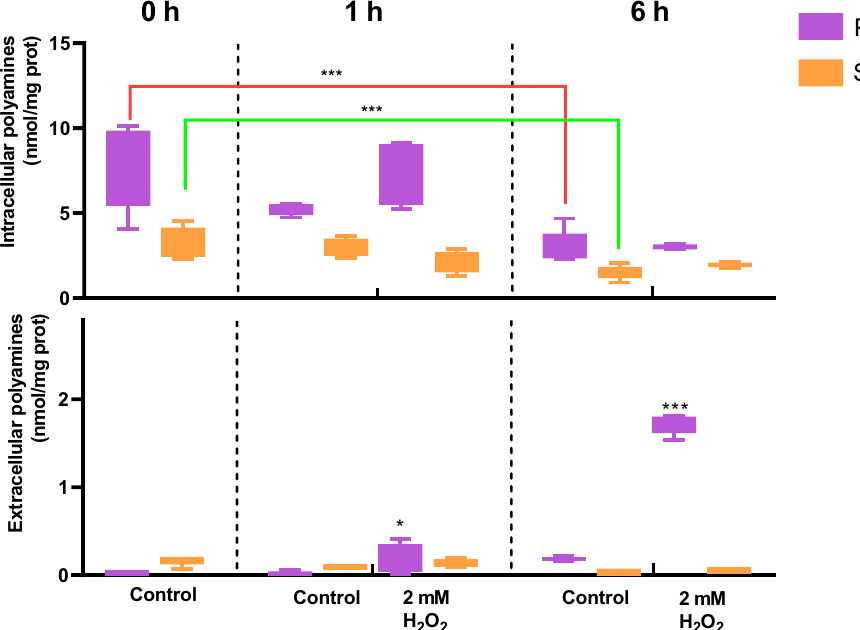
Figure 2. Concentrations of intracellular and extracellular polyamines in Pst DC3000 in response to oxidative stress. Cells were grown for 6 h in control M9 media or M9 supplemented with H 2 O 2 at a final concentration of 2 mM. Polyamine concentrations were determined in the intracellular (top graph) and extracellular (bottom graph) spaces as described in Materials and Methods. Concentrations of polyamines were compared to those obtained under control conditions at 0 h using the Student’s t test. (*p < 0.05, **p <